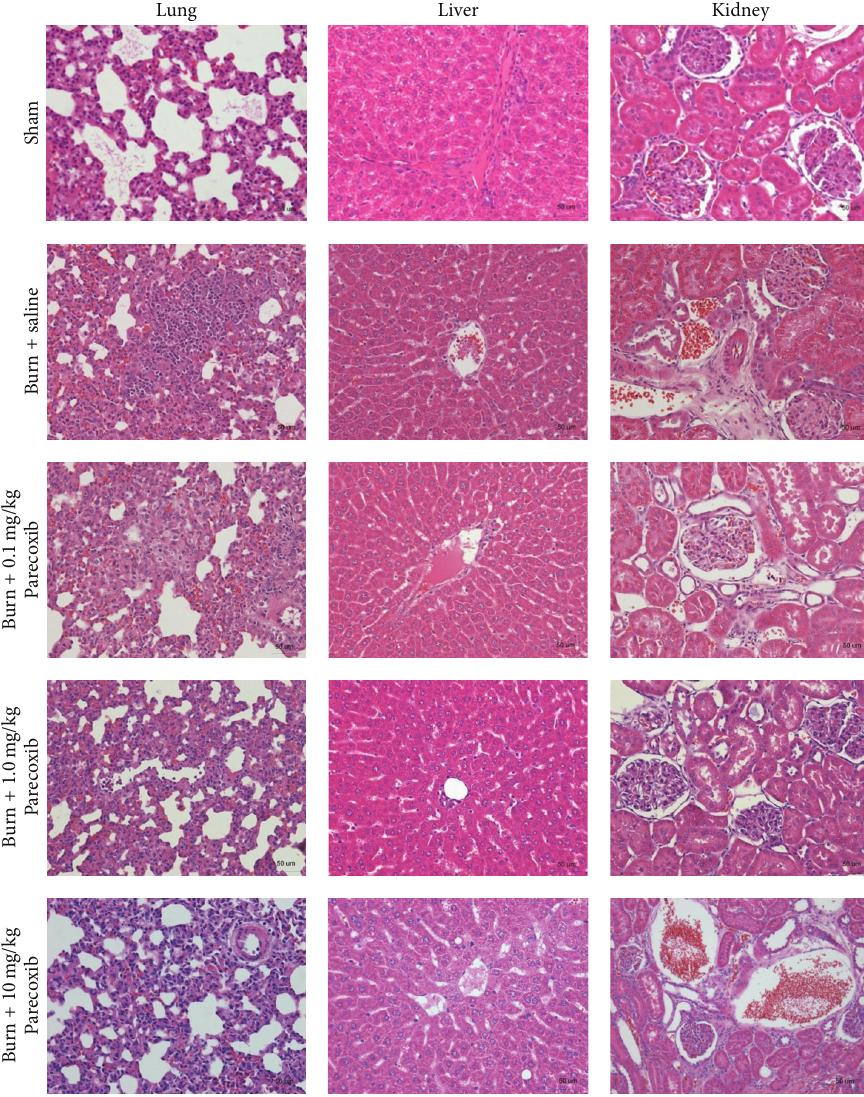
Figure 7: Histological examination of lung, liver, and kidney in Sham, burn + saline, burn + 0.1mg/kg Parecoxib, burn + 1.0mg/kg Parecoxib, and burn + 10 mg/kg, at 6h following